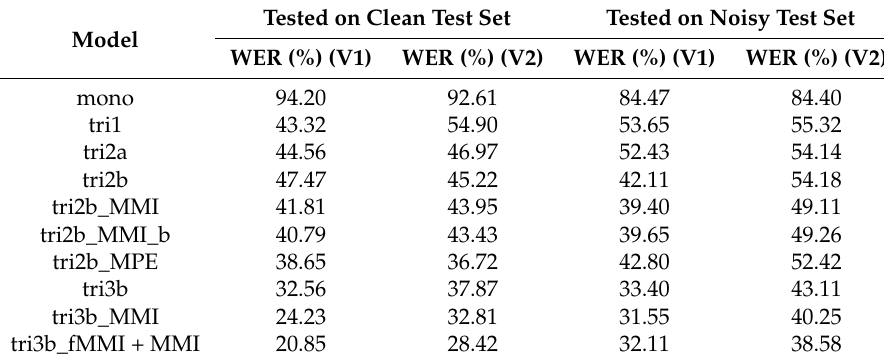
Table 4. WER of models trained on noisy data.